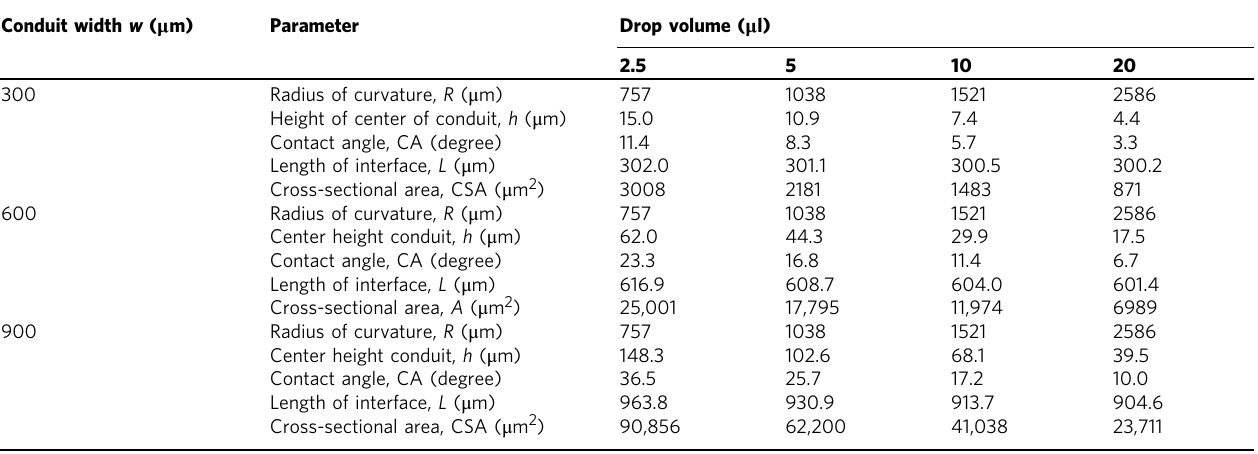
Table 2 Geometric parameters of drops and conduits Conduit width w ( μ m)